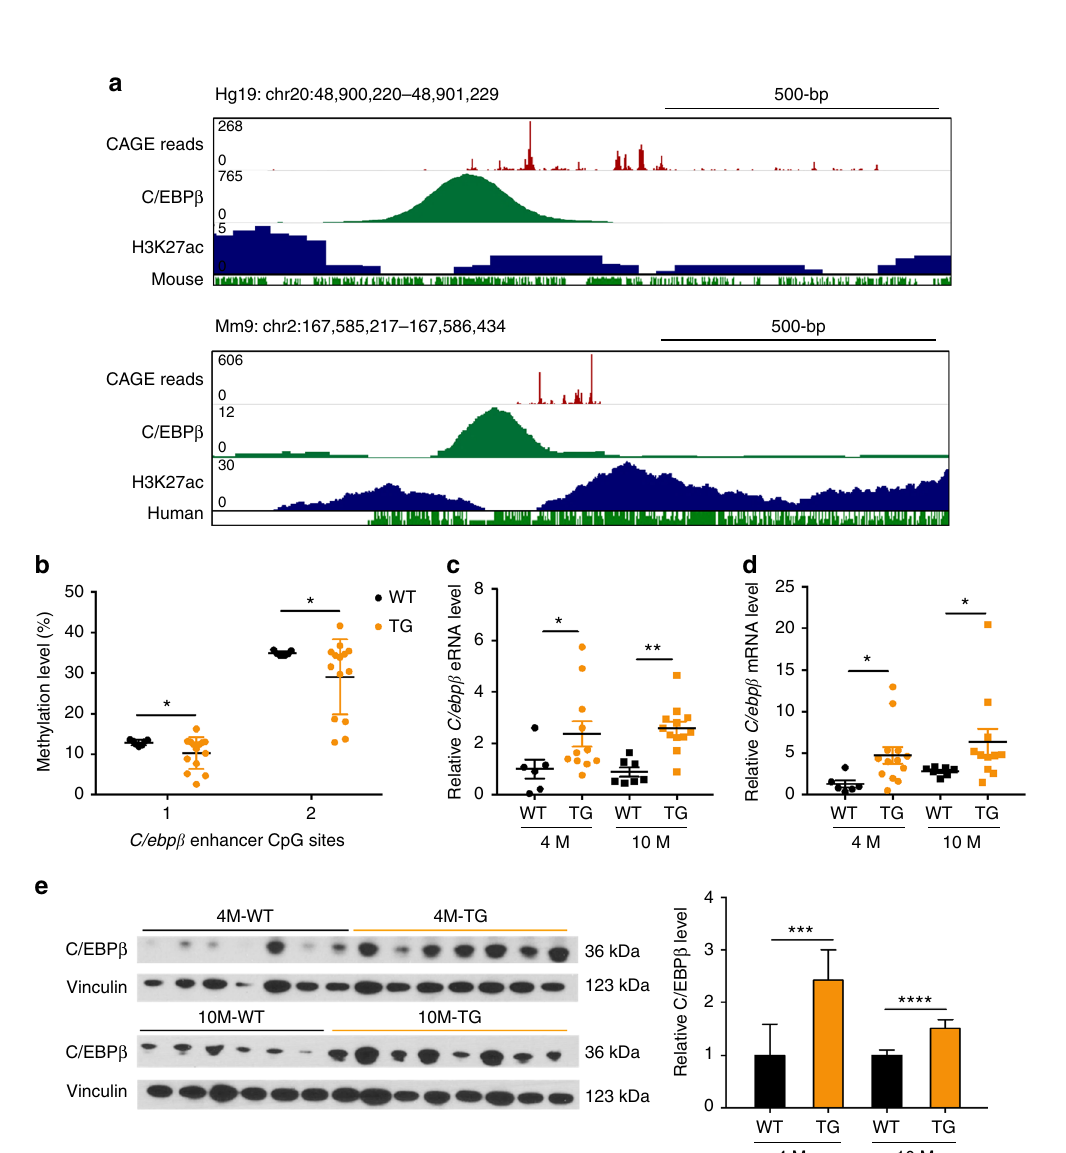
Fig. 4 C/EBP β enhancer functions to promote HCC tumorigenicity. a The monoallelic ( C/EBP β enh + / − ) and biallelic ( C/EBP β enh − / − ) deletions of C/EBP β enhancer in HepG2 and LO2 liver cells via CRISPR/Cas9 were con fi rmed by PCR. b , c qRT-PCR analyses of b C/EBP β eRNA and c C/EBP β mRNA levels in WT, C/EBP β enh + / − and C/EBP β enh − / − cells. C/EBP β eRNA/mRNA levels were calculated by the 2 − ΔΔ Ct method using 18s rRNA as internal control, and are presented as fold-changes against the average value of the WT group. d , e Cell proliferation of WT, C/EBP β enh + / − , and C/EBP β enh − / − cells was determined by colony-formation assays. Representative images of focus formation are shown. f , g Cell invasion of WT, C/EBP β enh + / − , and C/EBP β enh − / − cells was determined using Matrigel chambers. Representative images of crystal violet-stained invaded cells are shown. h , i Xenograft tumors formed by WT, C/EBP β enh + / − , and C/EBP β enh − / − cells are shown in the images. Mean xenograft tumor volumes were plotted against days after injection. Data are presented as mean ± SD. * P < 0.05; ** P < 0.01; *** P < 0.001 as calculated by unpaired two-tailed Student ’ s t -test ( b – g ), and two-way ANOVA ( h , i )